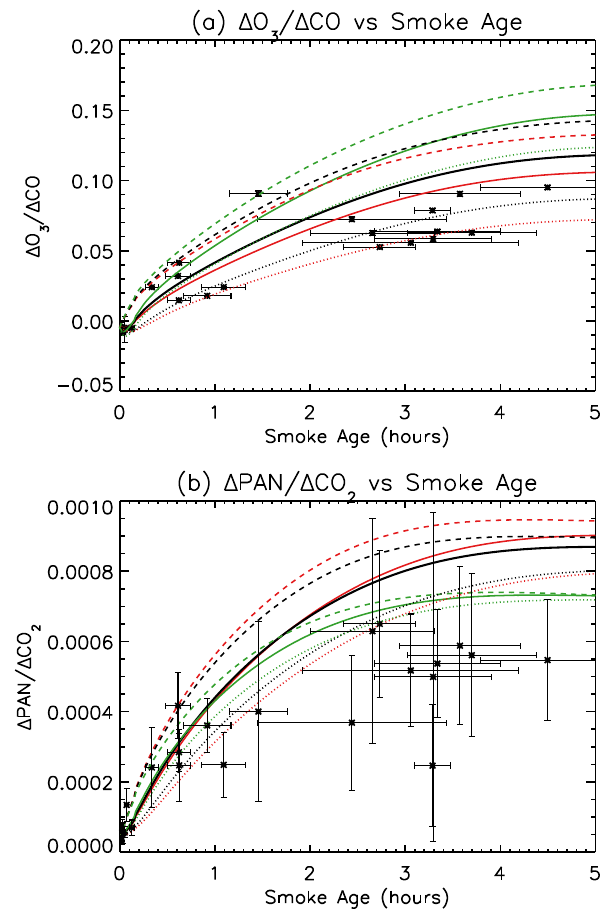
Figure 5. Enhancement ratios (molmol − 1 ) of (a) O 3 to CO and (b) PAN to CO 2 vs. estimated smoke age when the chemistry of the unidentified SVOCs is not included in the model. Asterisks are the measured mixing ratios, with the horizontal error bars showing the uncertainty in the estimated age and the vertical error bars showing the uncertainty in the measurement. Red, black, and green are ASP results for the slow, best fit (medium), and fast plume dilution rates. Dashed lines are for above-plume photolysis rates, while solid lines are for the middle of the plume, and dotted lines are for the bottom of the plume (see the legend in Fig.